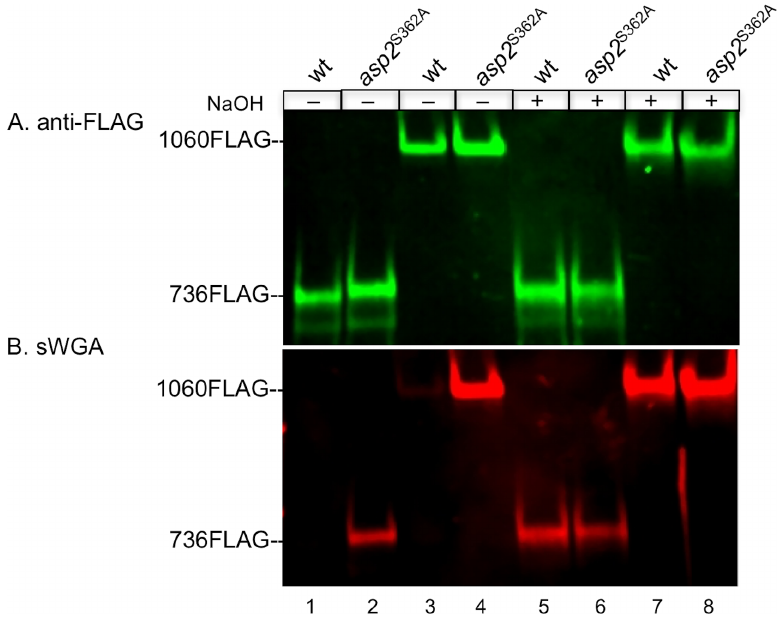
Fig 2. Saponification analysis of exported GspB736flag and GspB1060flag. A) GspB736flagand GspB1060flag secreted from parentalstrains PS1225(lane 1) and PS921 (lane 3) and the corresponding derivative strains harboringthe S362A mutation within asp2 , PS3539(lane 2), PS3540(lane 4) were separated by SDS-PAGE and subjectedto Western blot analysisusing anti-FLAG antibodiesto detect GspB levels. Saponifiedreactionproducts were obtainedthrough incubation with 100 mM NaOH to release ester- linkedacetate (lanes5–8). B) Blot A was simultaneously probedfor GlcNAc reactivity of GspB736flag and GspB1060flag before and after saponfication. GlcNAc reactivity was assessedby lectin blot analysisusing biotinylated sWGA as a GlcNAc probe. Western and lectin blot analysisof secreted GspB variants are representative of 3 different genetic transformants analyzedfrom each